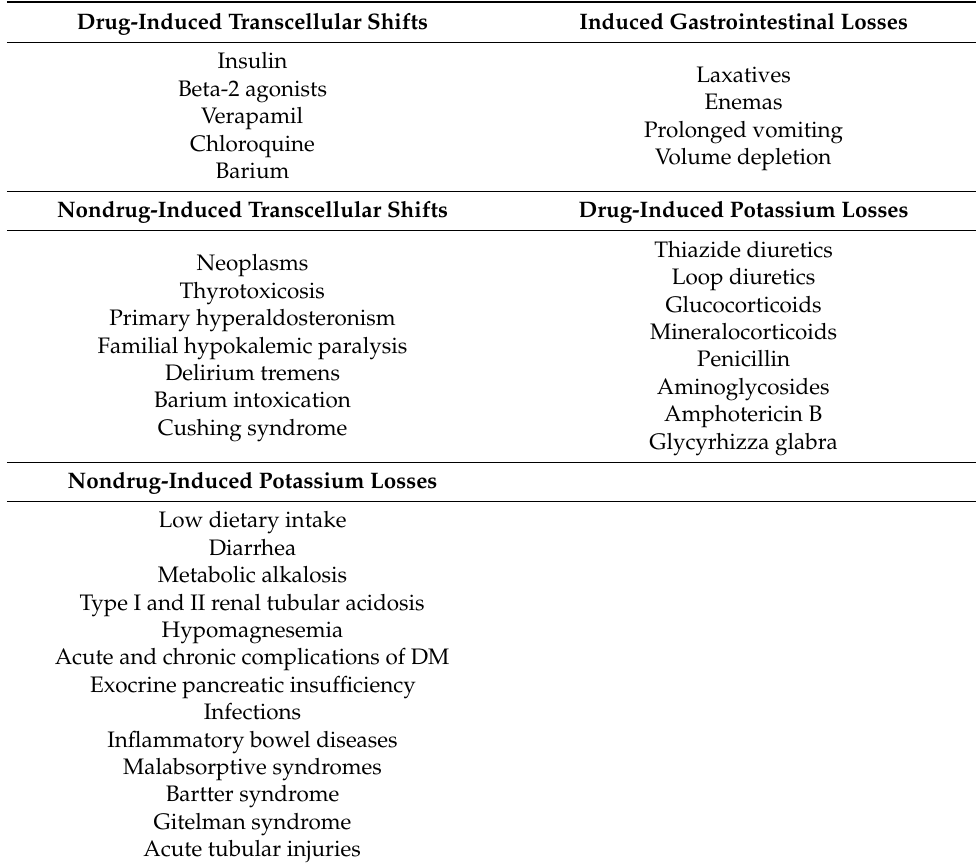
Table 1. Main mechanisms of